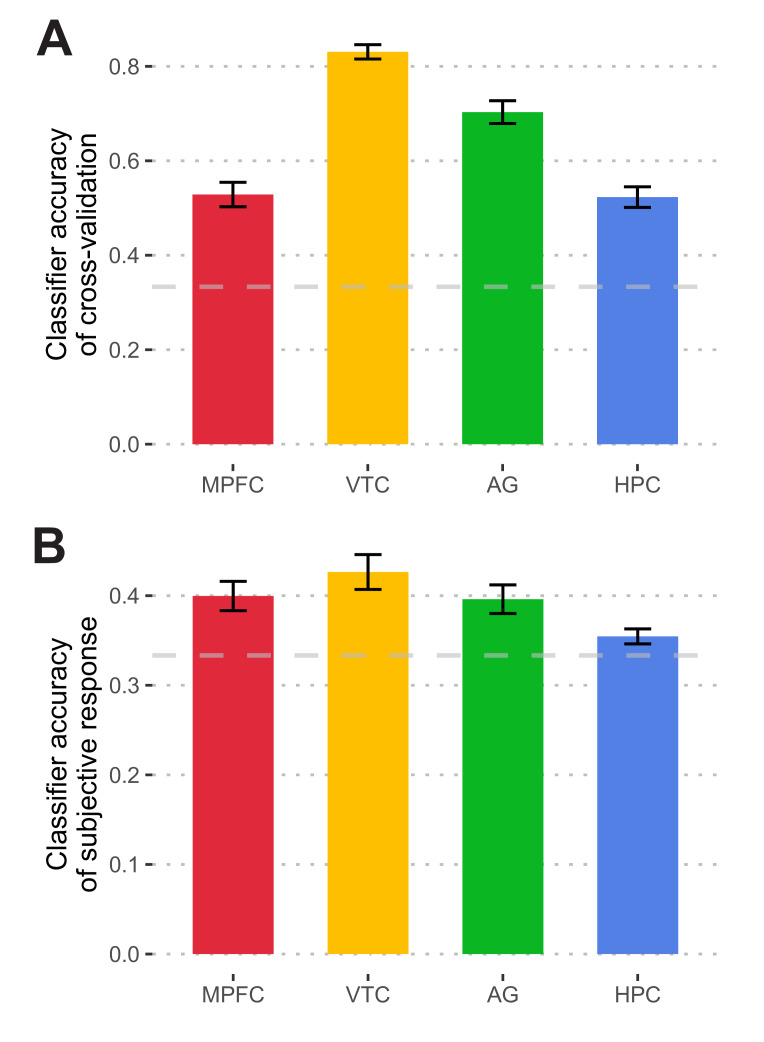
Classifier performances.(A) Cross-validation accuracy for functional localizer data. To examine the performance of the classifier, a leave-one-run-out cross-validation procedure was conducted on functional localizer data. The average accuracy was significantly above the chance level (ranging from 52.3% to 83.1%, all p-values <0.001, survived FDR correction). (B) Classifier accuracy in predicting subjective responses during the final test. Classifier outputs predicted subjects’ subjective responses significantly better than the chance level in the MPFC, VTC, and AG (ranging from 39.6% to 42.6%, all p-values <0.001, with FDR correction), but not in HPC (35.5%, t(18) = 0.96, p=0.35). Error bars indicate within-subject standard errors. The dashed line indicates the chance level.